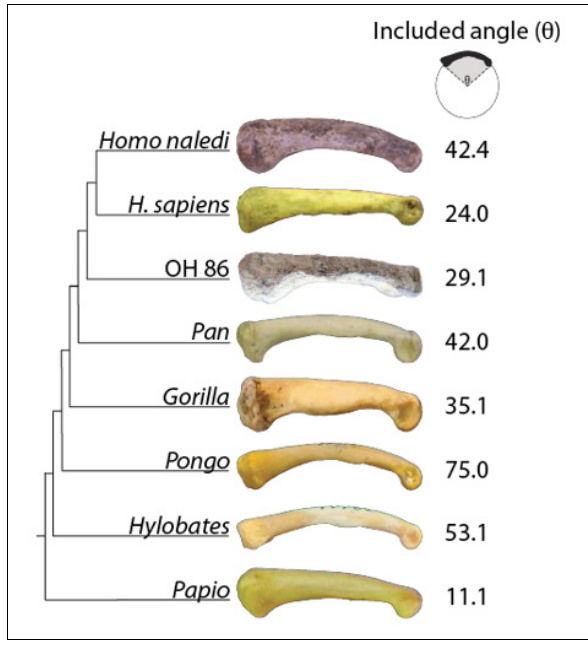
Figure 1: Cladogram of baboons ( Papio ), gibbons ( Hylobates ), orangutans ( Pongo ), gorillas ( Gorilla ), chimpanzees ( Pan ), an indeterminate hominin (OH 86), and genus Homo . The branches are tipped with representative photographs of manual proximal phalanges in lateral view, together with mean degrees of curvature of the proximal phalanx, as measured by computing the included angle ( θ ). Data sources for θ : Stern et al. 10 (humans), Jungers et al. 6 (non-human primates), and Domínguez-Rodrigo et al. 11 (OH 86). The θ value for H. naledi was calculated by one of us (S.M.S.) as the mean of digits II (42.71), III (46.49), IV (48.44), and V (31.88) of hand 1, the right hand of an adult (see Kivell et al. 9 for further details).